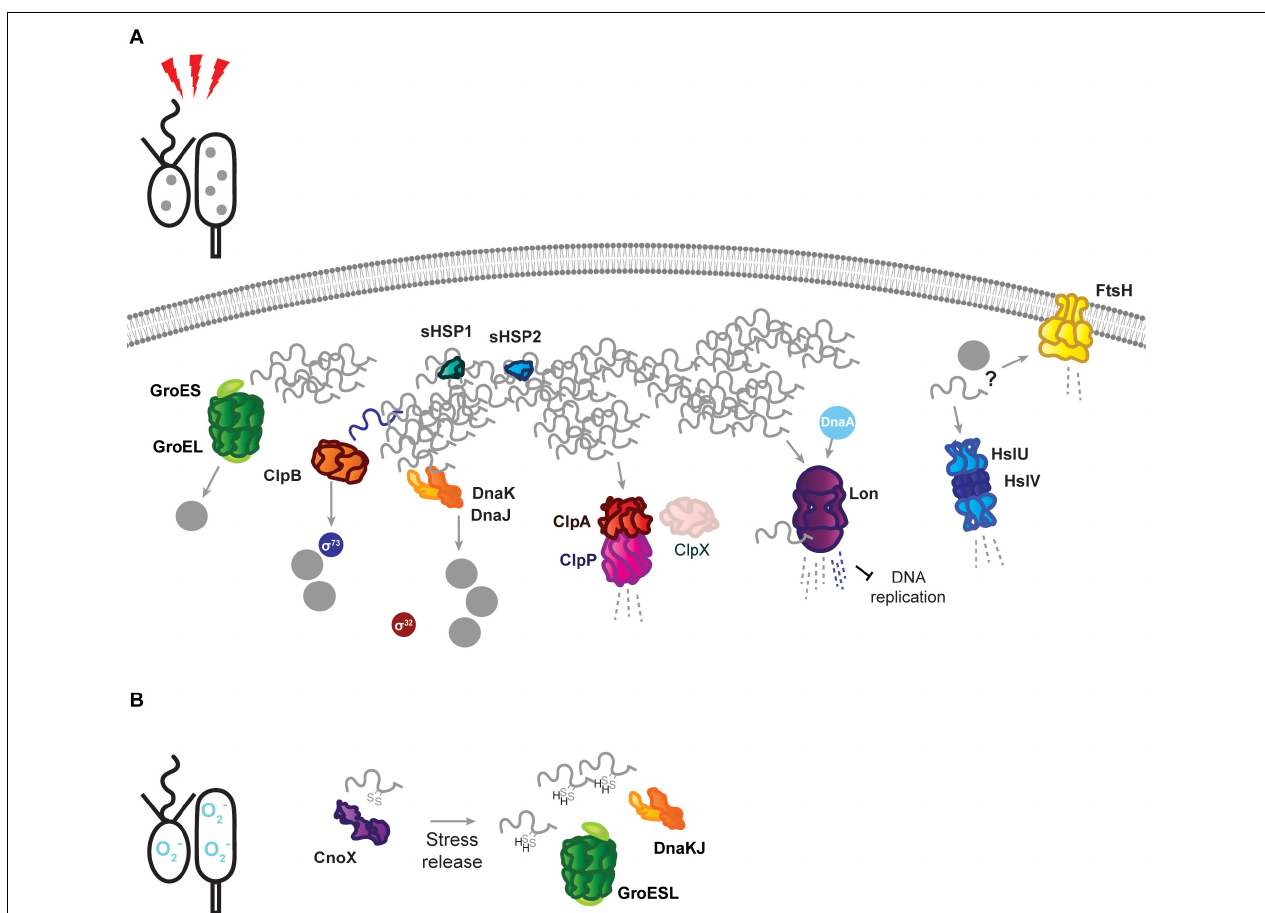
FIGURE 2 | Stress response tasks of the Caulobacter crescentus PQC network. (A) Heat stress induces unfolding of the susceptible proteome, and unfolded proteins (gray squiggles) are incorporated into insoluble protein aggregates (gray dots). Known interactions during stress are indicated by protein name in colored circles. DnaKJ/E, ClpB, and GroESL participate in protein refolding and disaggregation. The small heat shock proteins organize unfolded proteins. ClpAP and Lon participate in degradation of unfolded proteins, in addition to regulatory roles. The proteases FtsH and HslUV are upregulated in response to proteotoxic stress, but it is unknown whether they contribute to degradation of unfolded proteins or regulatory substrates. (B) Oxidative stress results in oxidation of proteins and draining of the hydrotrope ATP, which can influence folding state. The holdase CnoX interacts and is capable of reducing disulfide groups of proteins, and protects them from aggregation until active GroESL and/or DnaKJ/E are available to refold these proteins. Membrane and DNA images created with Biorender (Biorender.com).